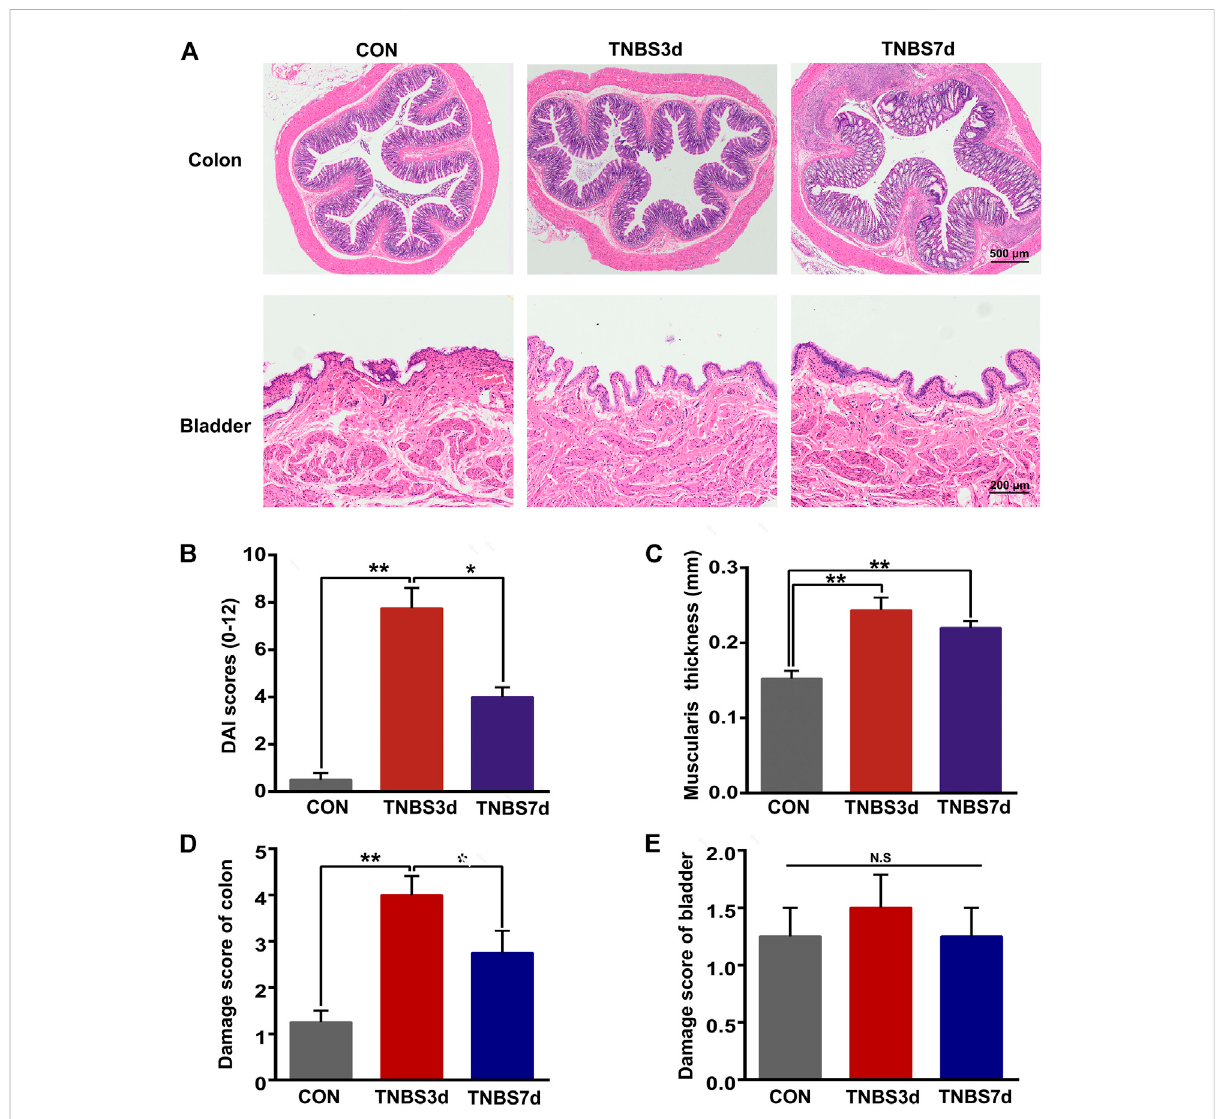
FIGURE 1 Histological changes of the distal colon and bladder in TNBS-induced colitis. (A) Representation of H&E staining of the distal colon (upper) and bladder(lower),andTNBStreatment ledtoin fl ammationofthedistalcolonbutnot thebladder. n=4foreachgroup. (B) Histogramshowed thatthe DAI score was signi fi cantly increased at day 3 after TNBS instillation, and the increased DAI score was partially recovered at day 7 post-TNBS. * p < 0.05 and ** p < 0.01 by Kruskal – Wallis H-test. (C) Histogram showed that muscularis propria thickness was signi fi cantly increased at days 3 and 7 after TNBS instillation.** p < 0.01 by one-way ANOVA followed by Newman – Keuls post hoc tests. (D) Histogram showed thehigher damage score ofthedistalcolonafterTNBStreatment,especiallyatday3post-TNBS.* p < 0.05,** p < 0.01byKruskal – WallisH-test. (E) Nosigni fi cantdifferencesin the damage score were detected in rat bladder among three groups by the Kruskal – Wallis